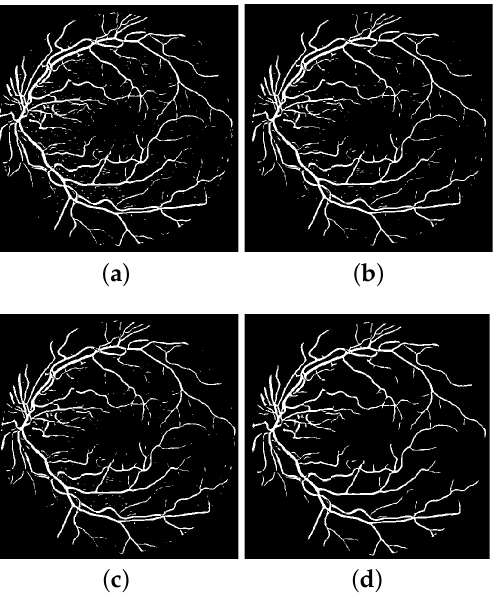
Figure 9. The post-processing module’s output. ( a ) mask ( b ) marker ( c ) image morphologically rebuilt and ( d ) retinal vessels’ ultimate binary or segmented